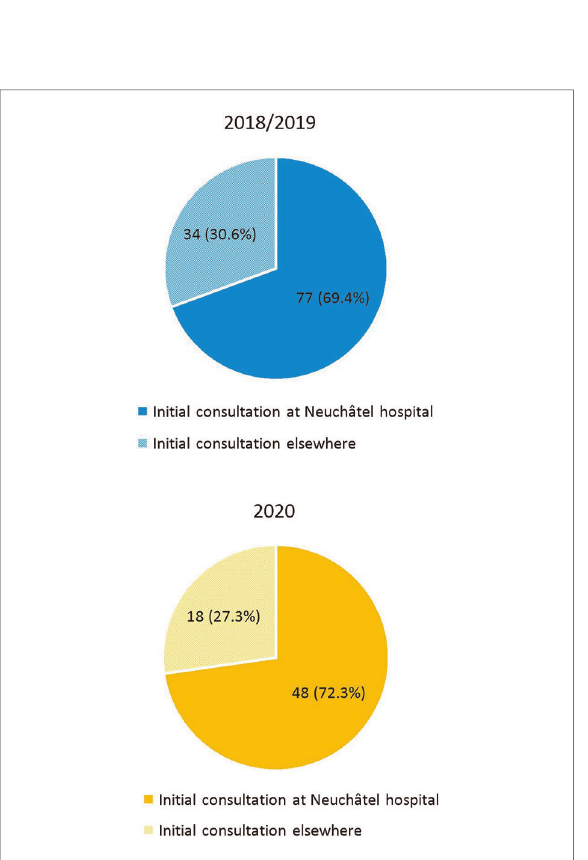
FIGURE 4 Place of initial consultation: at Neuchâtel hospital or outside the hospital (general practitioner, medical center) in 2018/2019 and 2020.